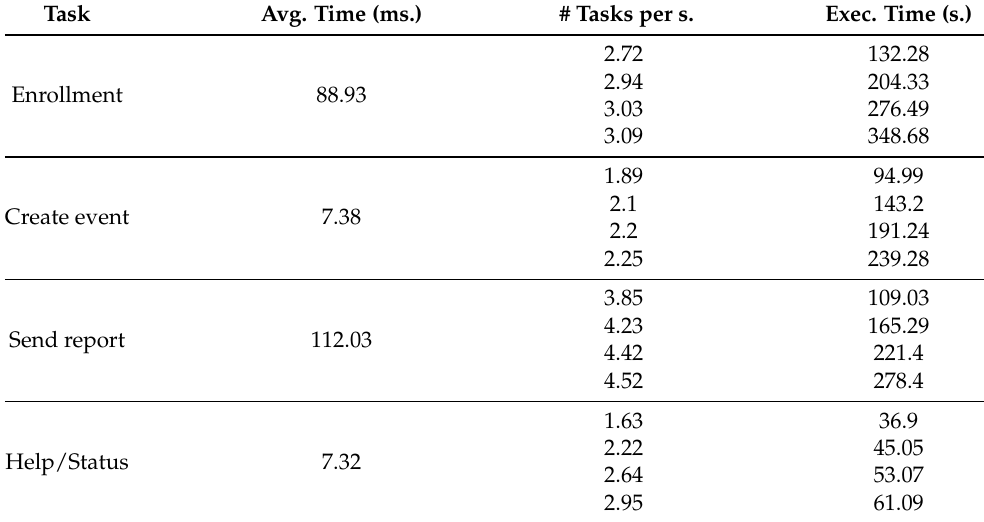
Table 2. Single processor: Execution time reported by different tasks executed by the Rimay application. Task Avg. Time